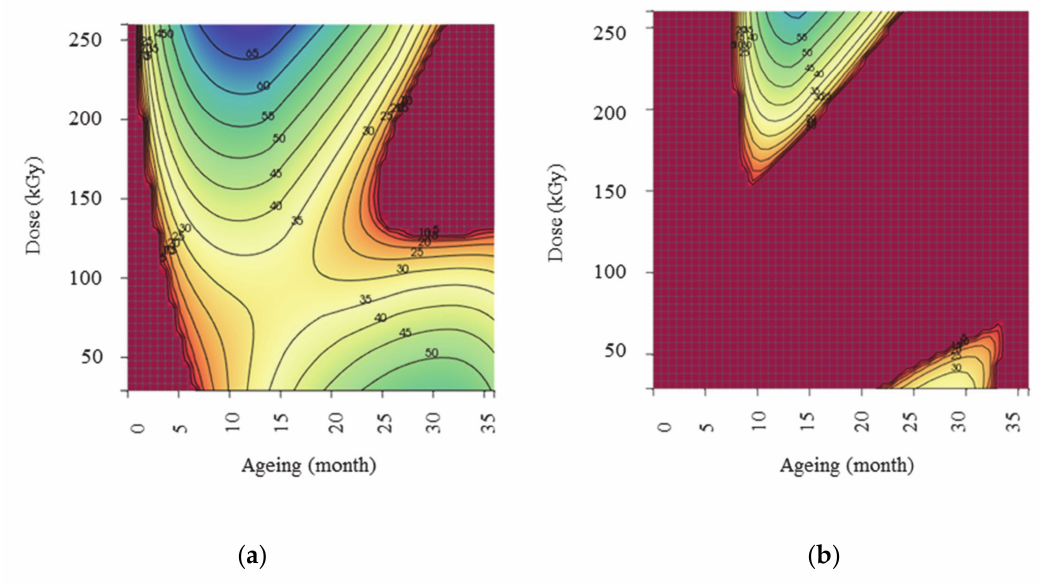
Figure 9. Desirability graphs of aging (months) vs doses (kGy), ( a ) for case 1, ( b ) for case